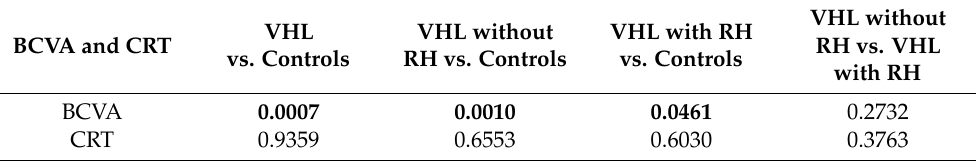
Table 9. Statistical significance ( p -value) BCVA and CRT in the analyzed groups. VHL VHL without BCVA and CRT vs. Controls RH vs. Controls vs.